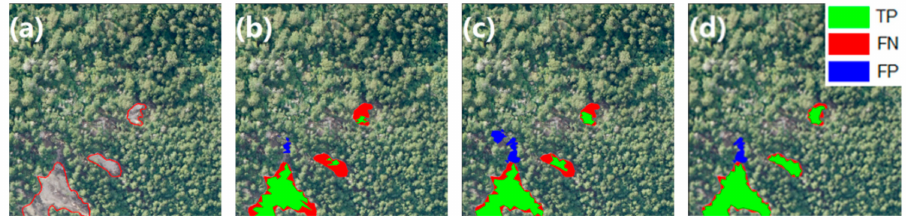
Figure 14. Missed landslide extractions. ( a ) Originally visual interpretation. ( b ) Extractions of ResNeXt50. ( c ) Extractions of ResNeXt50 + Improved FPN. ( d ) Extractions of ResNeXt50 + Improved FPN + L edge .